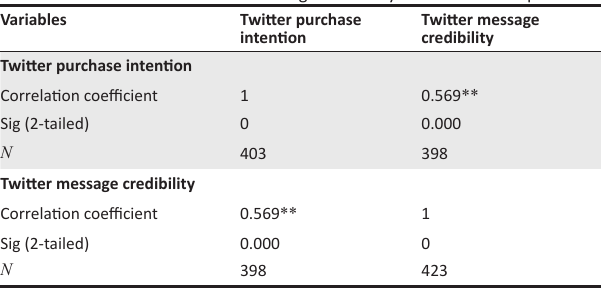
TABLE 2: Correlations for Twitter message credibility and intention to purchase.